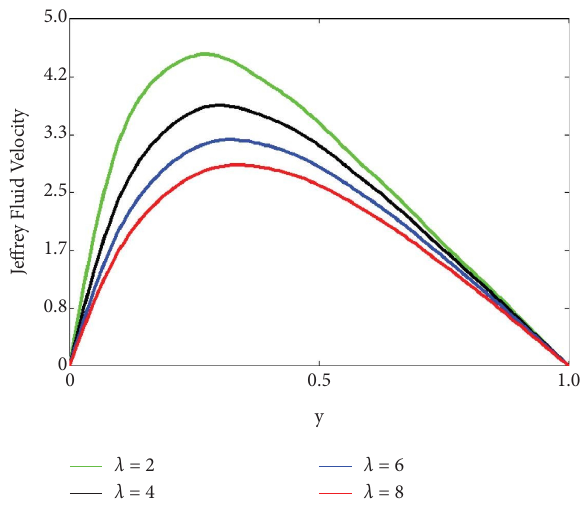
Figure 6: Te impact of diferent values of λ on ψ ( y, t )